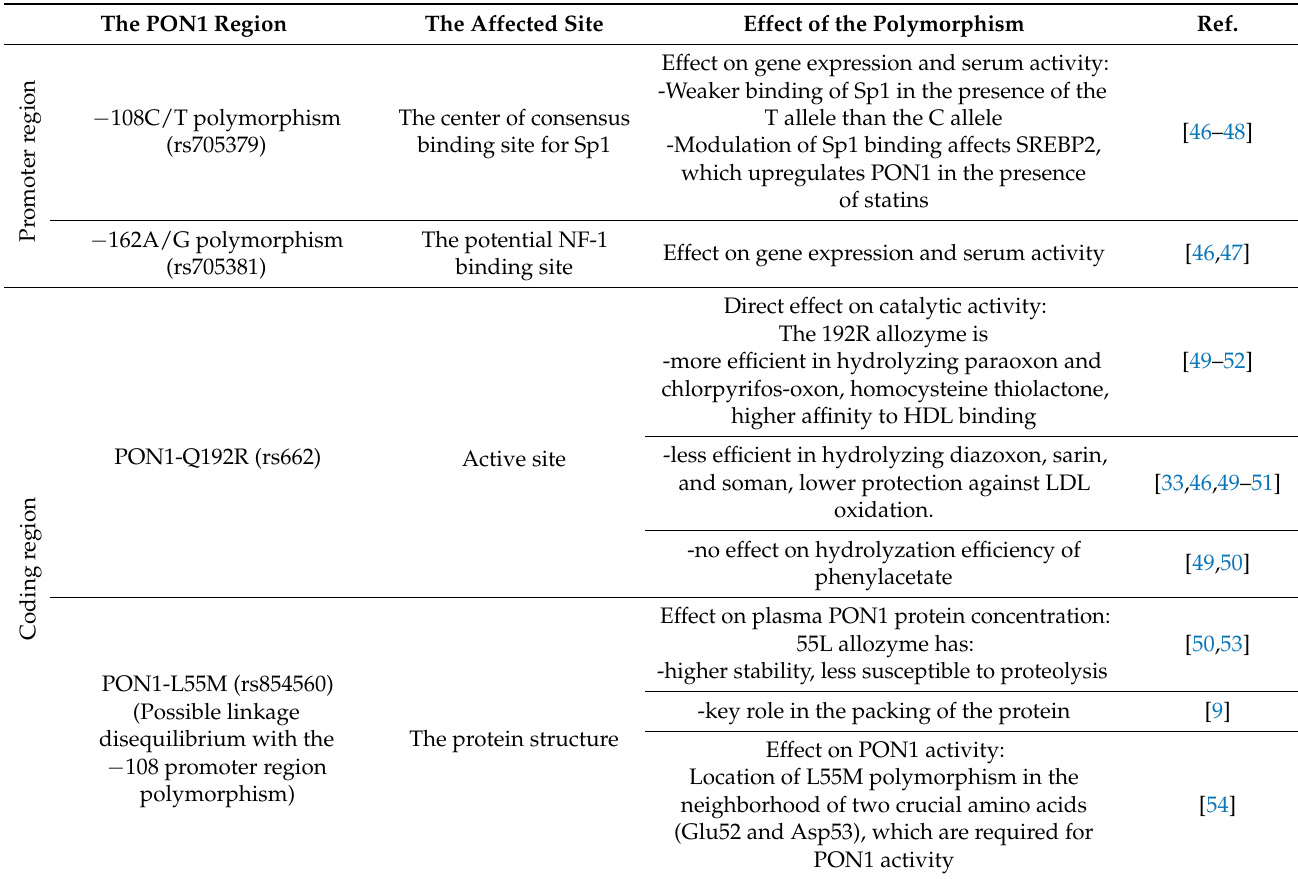
Table 1. PON1 polymorphisms affecting the enzyme structure and